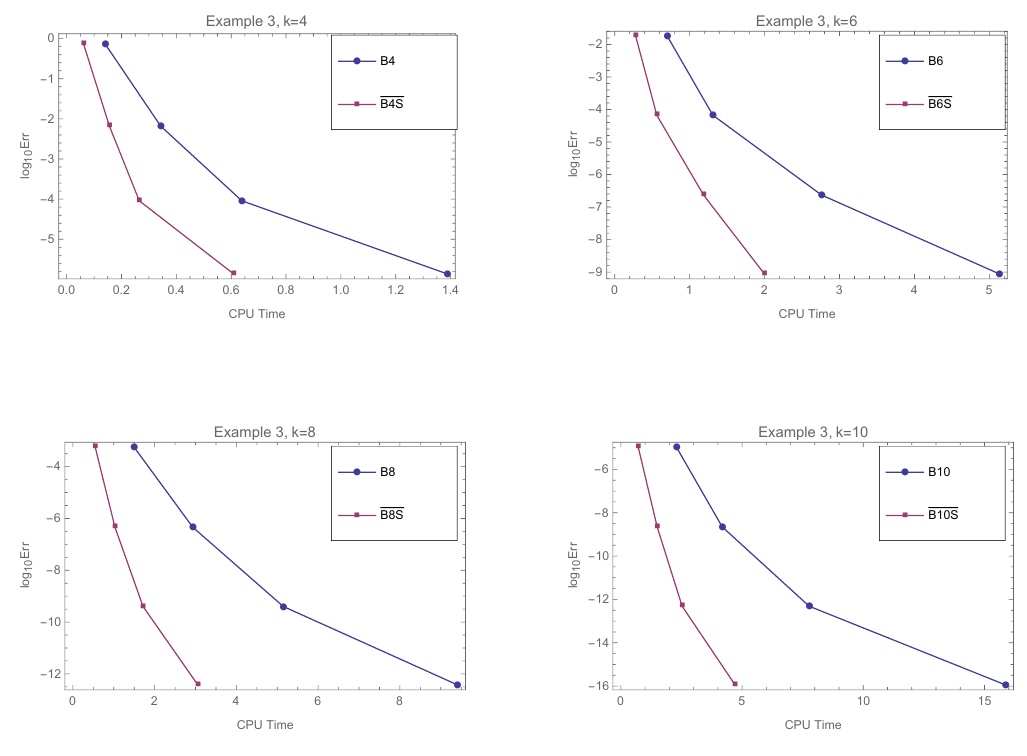
Figure 5. Efficiency curves for Example 3 comparing performances of usual